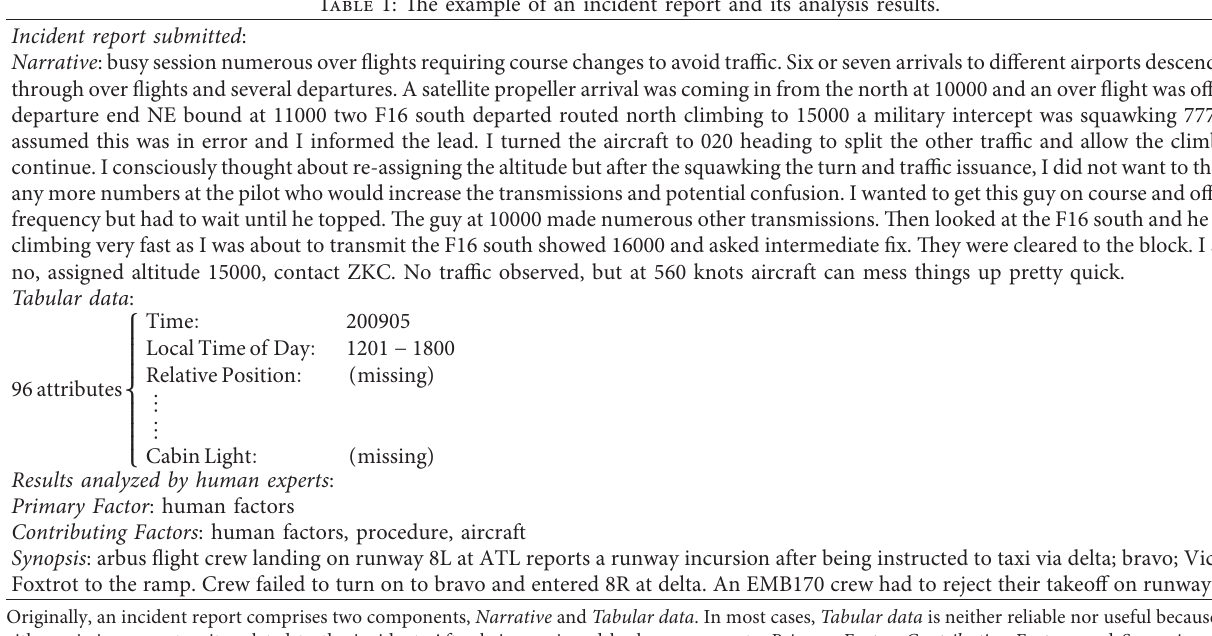
Table 1: The example of an incident report and its analysis results.